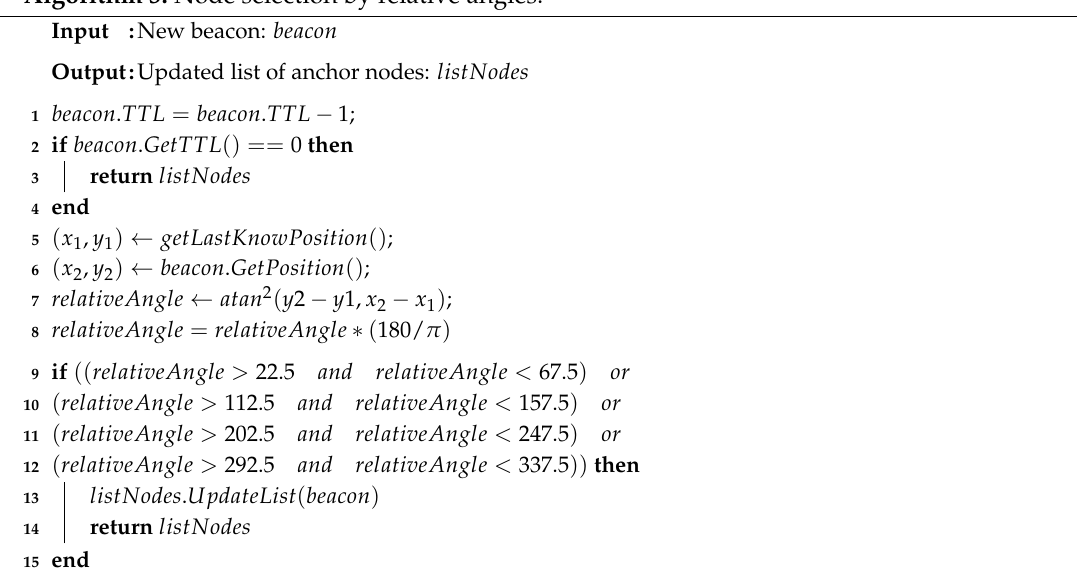
Algorithm 3: Node selection by relative angles.